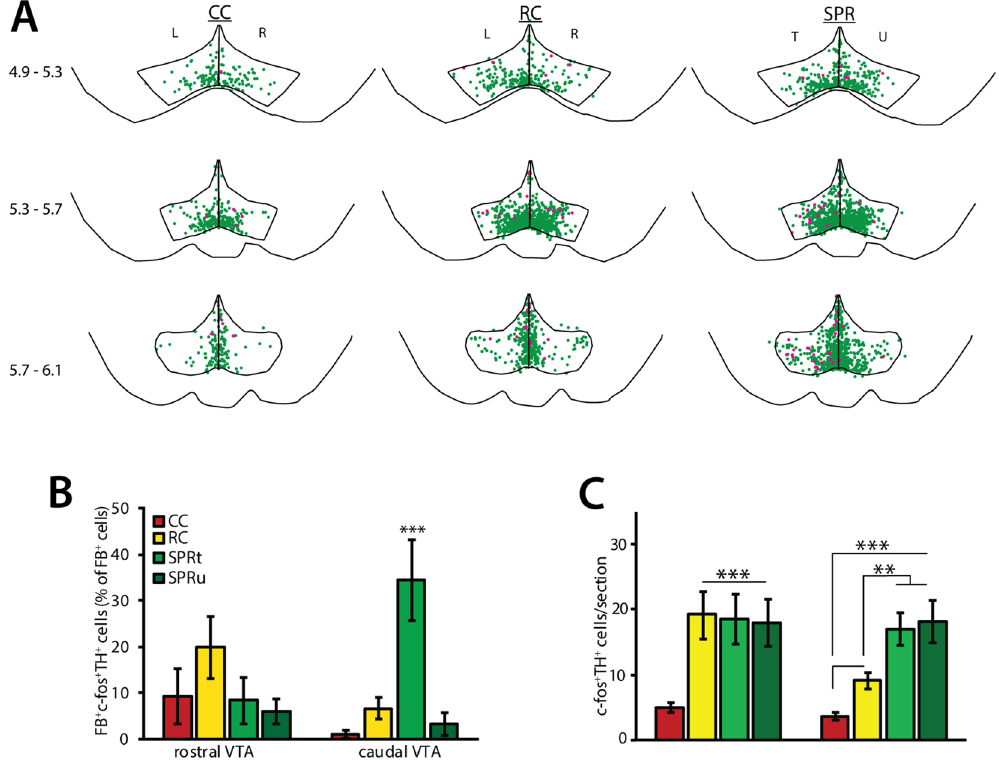
Figure 3. c-fos expression in dopaminergic neurons during successful acquisition (SA, N = 8 per group). SPR = single pellet reaching, RC = reward control, CC = cage control. T = trained, U = untrained, L = left, R = right hemisphere. Asterisks indicate significant differences ( * p < 0.05, ** p < 0.01, *** p ≤ 0.001 in Tukey’s HSD test), values are mean ± s.e.m. ( A ) Superposition of TH + c-fos + (green) and FB + TH + c-fos + (pink) neurons neurons in rostral and caudal VTA